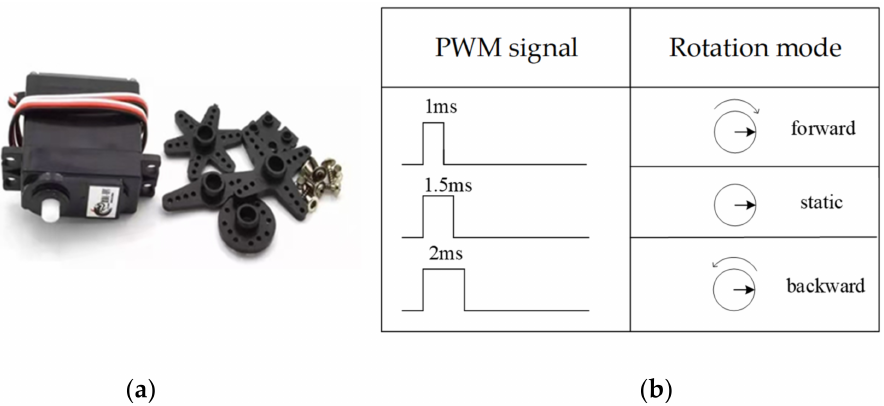
Figure 12. DC motor for driving the origami structure: ( a ) DS04-NFC motor; ( b ) rotation mode with PWM